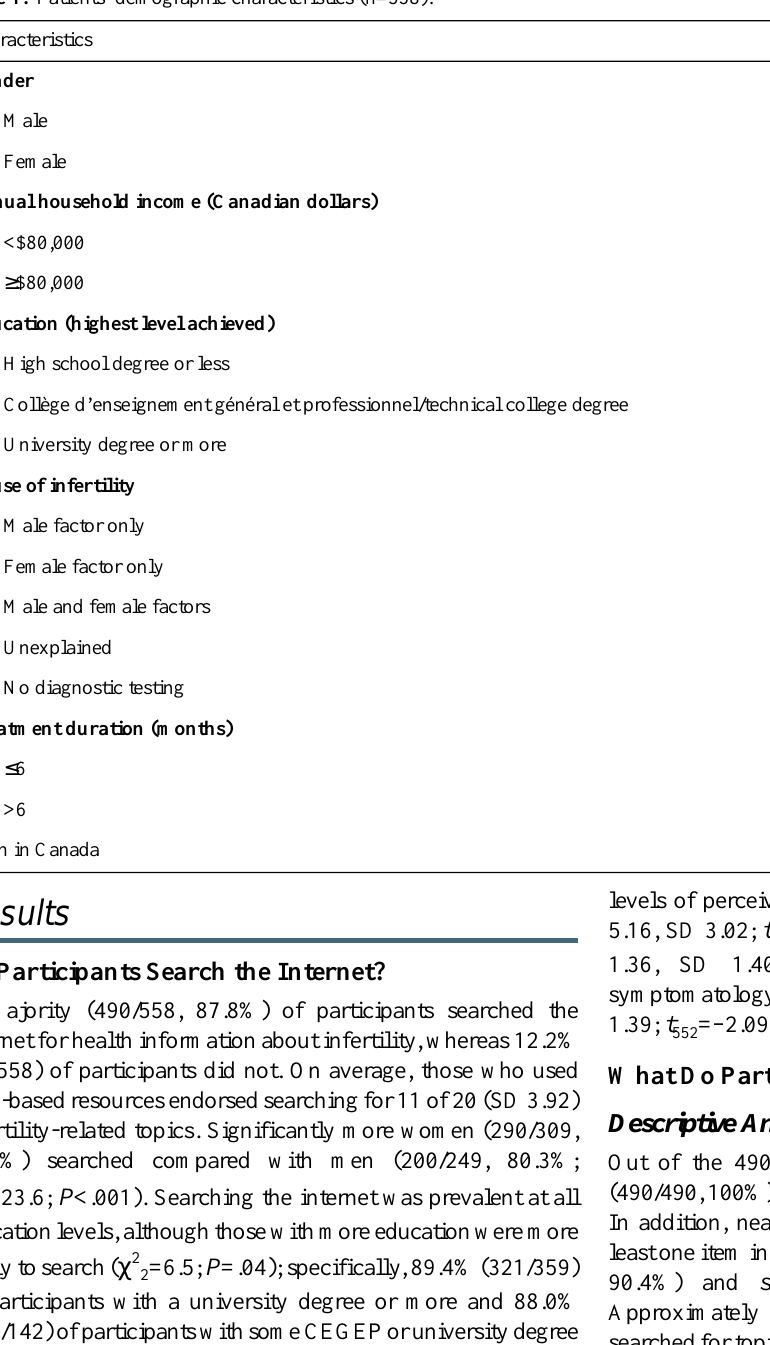
Table 1. Patients’demographic characteristics